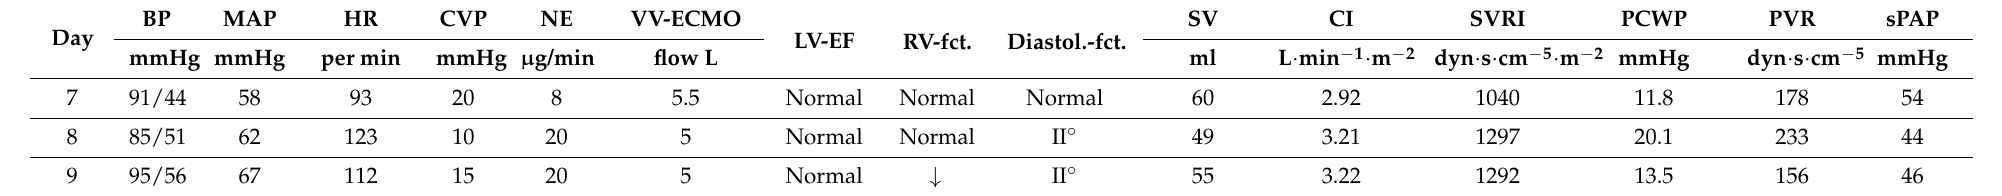
ICU parameters, vasopressor therapy, venovenous ECMO flows, and non-invasive critical care echocardiographic (CCE) and vital parameters of patient #2. BP: blood pressure; HR: heart rate; CVP: central venous pressure; NE: norepinephrine; VV-ECMO: venovenous ECMO; LVEF: left ventricular ejection fraction; RV-fct.: right ventricular function; Diastol. fct.: